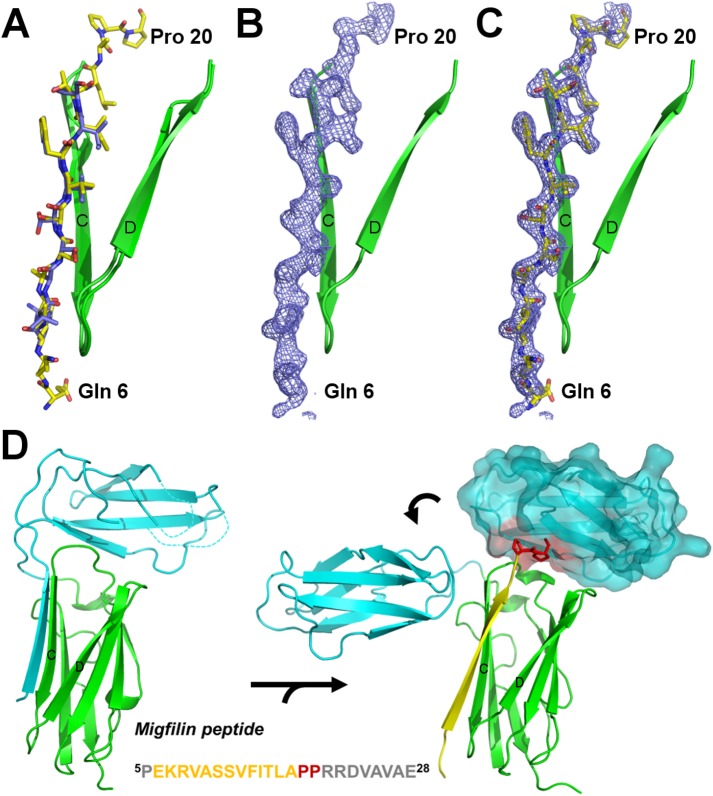
Migfilin peptide binding on IgFLNa∆A20–21.
A Comparison of IgFLNa21-migfilin complex structure (peptide shown in orange) [18] (2W0P) with the structure reported here. Only the CD face and peptide are shown. B Electron density map (F
o
–F
c) of migfilin peptide shown at σ level 2.5 calculated from the refined model without the peptide. C Same as panel B with peptide shown. D Migfilin peptide binding causes major conformational changes in IgFLNa20–21. The left panel shows the compact structure of IgFLNa20–21 from 2J3S [23]. On the right panel, the current structure and the compact structure (2J3S) are superimposed for IgFLNa21 and the compact conformation of IgFLNa20 is shown surface rendered. The two proline residues in the migfilin peptide (shown in sticks) cause a steric clash (red) for the compact orientation of IgFLNa20. The peptide sequence is given below. Density for the amino acids in the peptide written in gray was not seen.